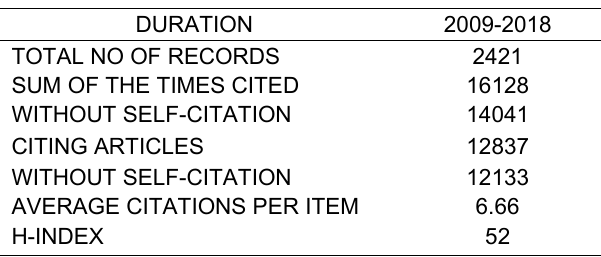
Table 1. Citation summary of the WoS